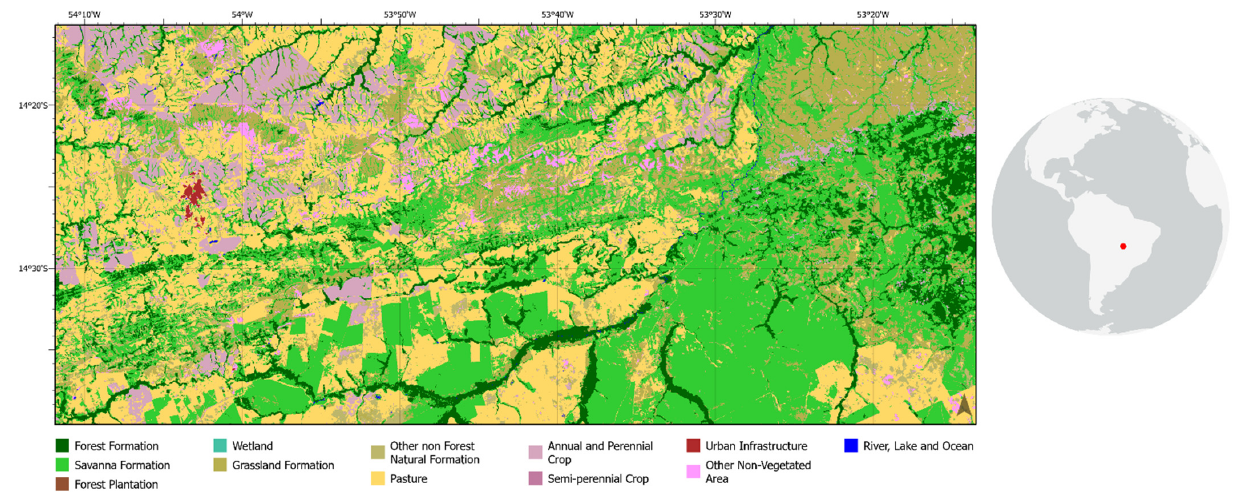
Figure 7. Map showing the MapBiomas Collection 4 labels from 2018. This extent was used for the qualitative assessment. Legend colors were chosen to be coherent with the MapBiomas Project.